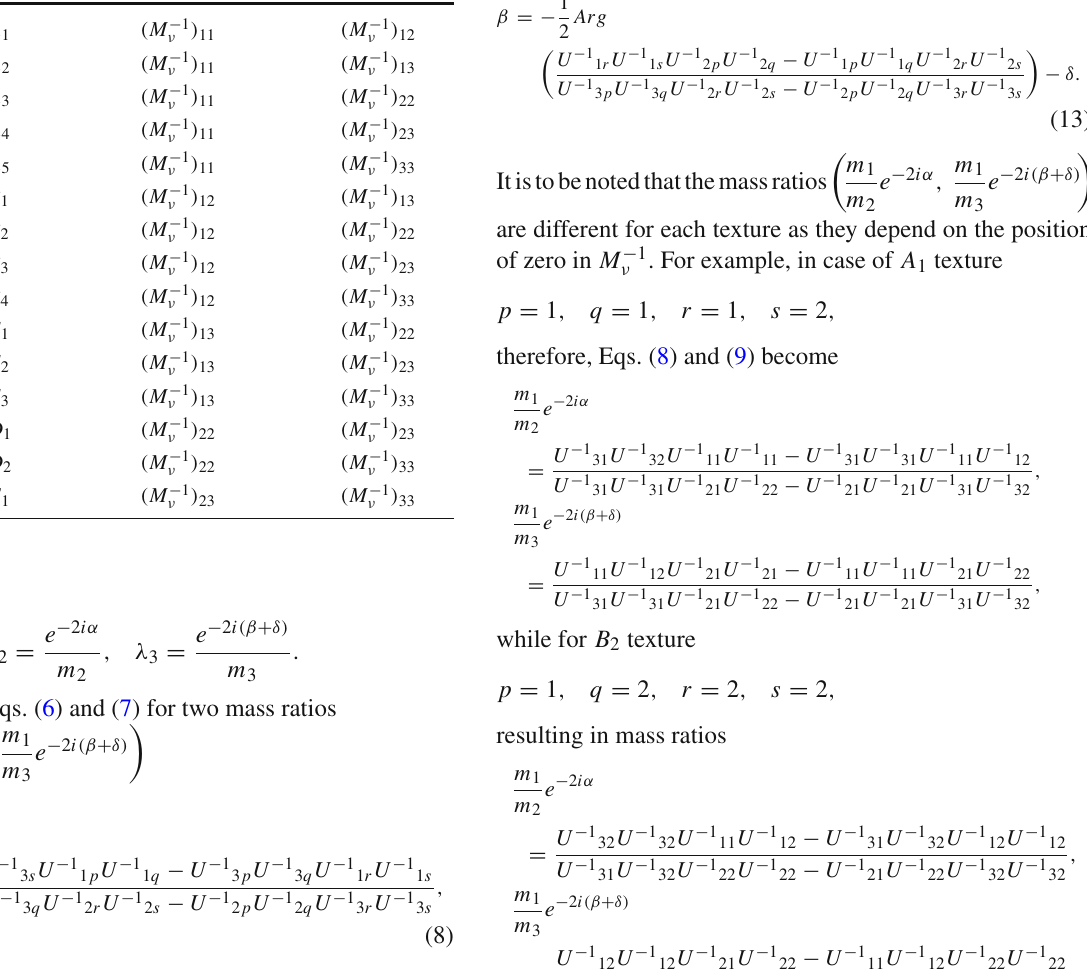
We have analytically solved the mass ratios for all possible two-zero textures which are shown in the Tables 2, 3 and 4. The two mass-squared differences (cid:9) m 2 (cid:14) (cid:14) (cid:14) (cid:9) (cid:14) = − m 2 m 2 m 2 alongwith mass ratios 32 3 2